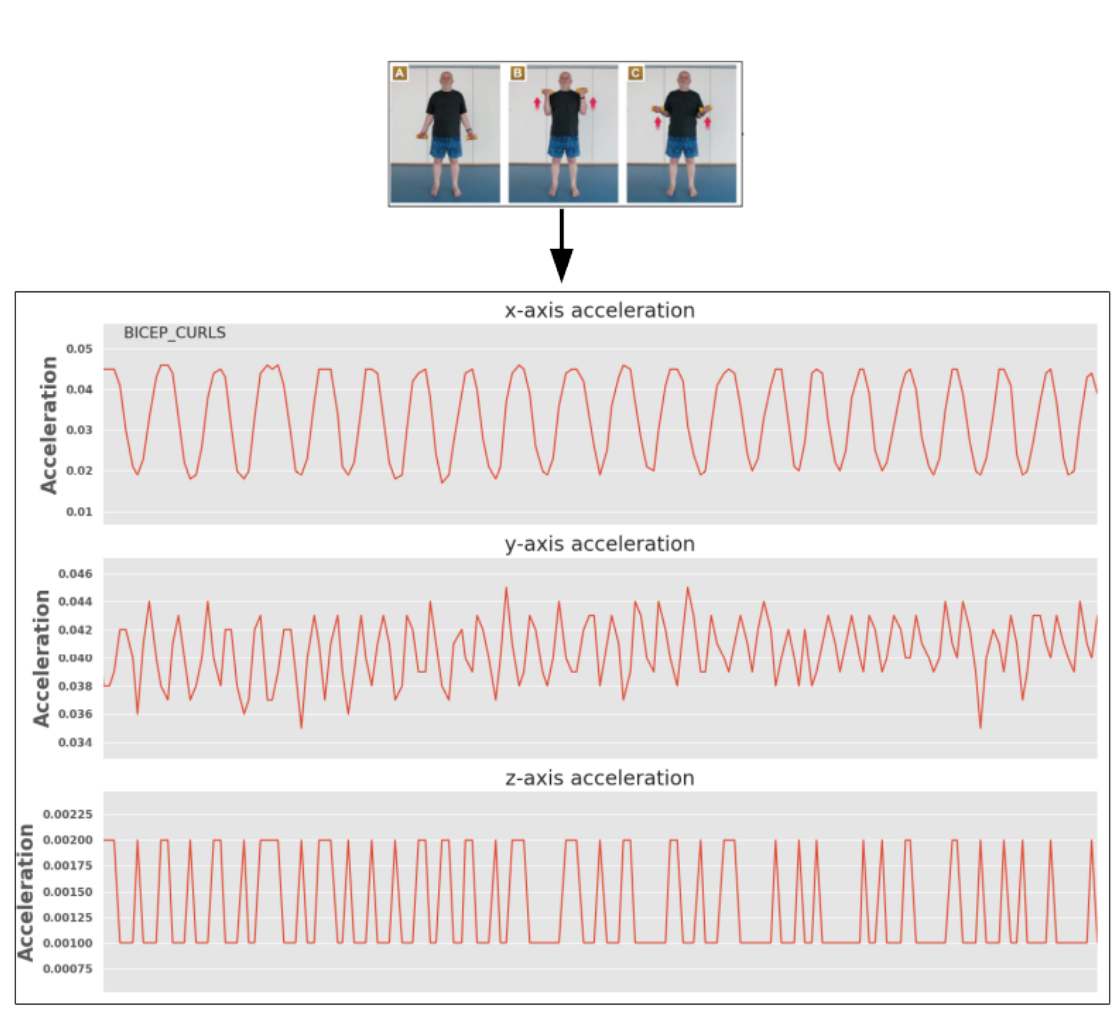
Figure 10. Bicep